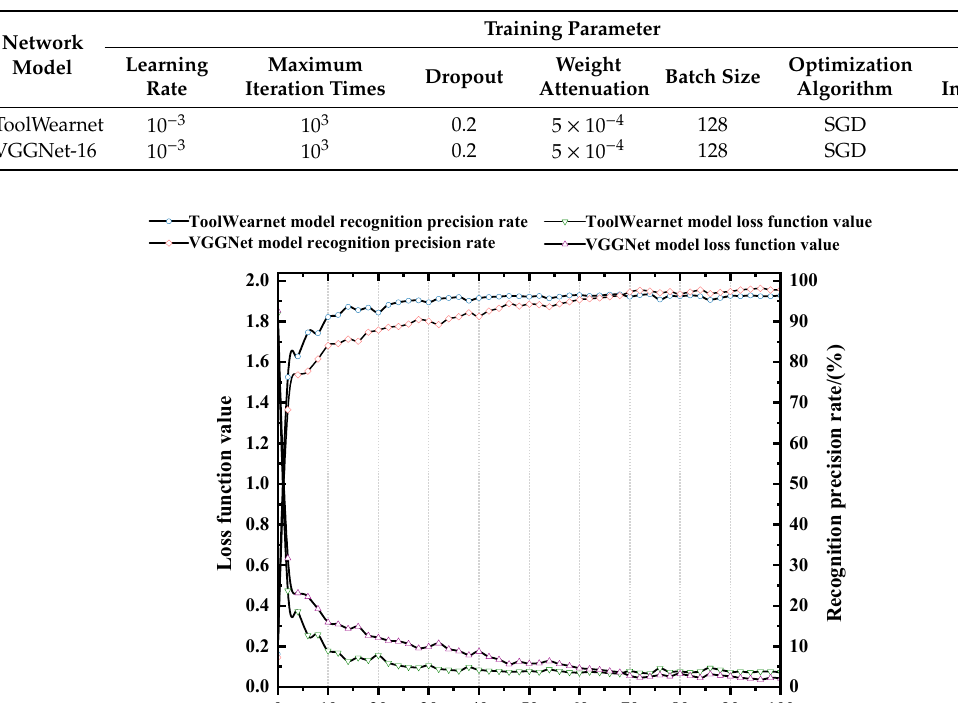
Table 6. The detailed training parameters for the two models.